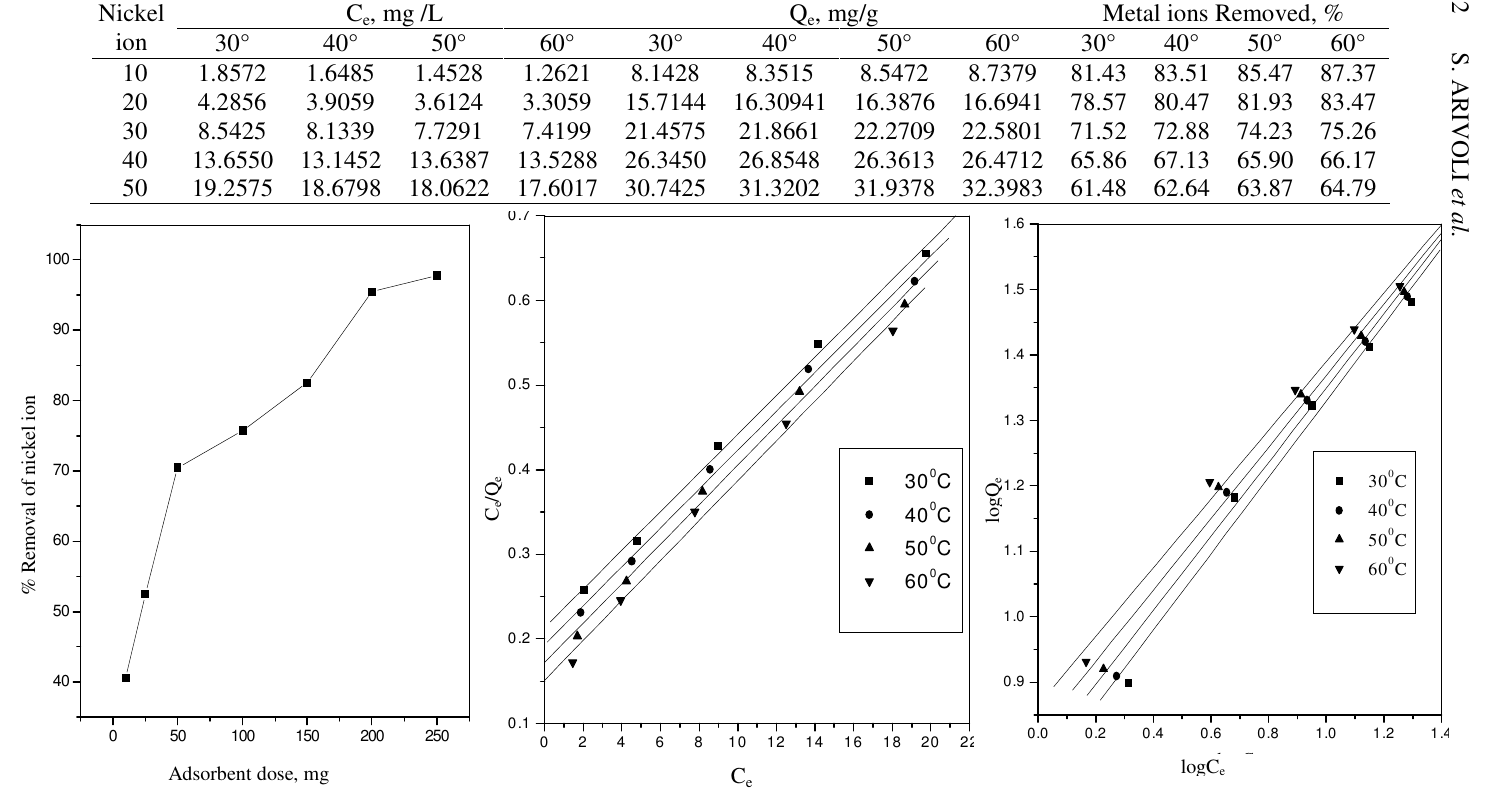
Figure 2 . Effect of adsorbent dose on the adsorption of nickel ion.